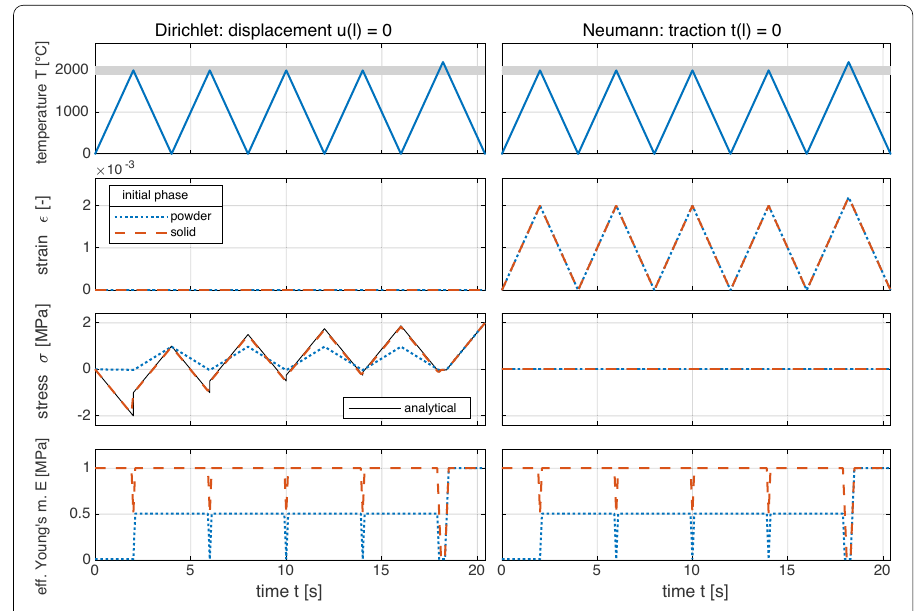
Fig. 4 Stress and strain over time for the Dirichlet and Neumann scenario with initially powder or solid material induced by repeated partial melting with T s < ˆ T 1 < T l and a final full melt with ˆ T 2 > T l . Phase change interval in gray